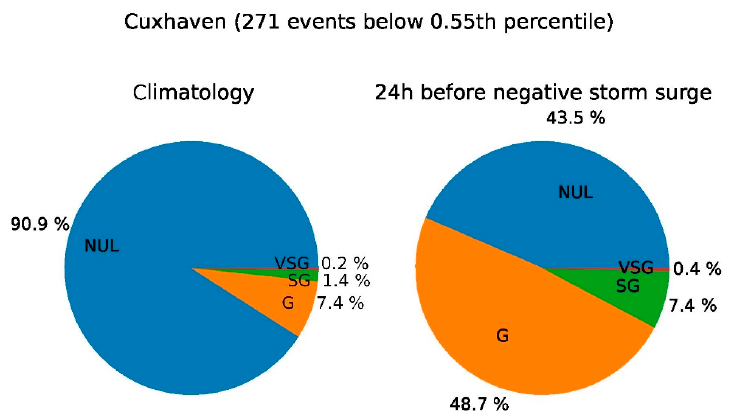
Figure 10. Left: Mean distribution of gale classes determined from daily means of ERA5 sea-level pressure for the entire period from 1950 to 2019. Right: Mean distribution of gale classes 24 h before ELW at Cuxhaven (LW below 0.55th percentile of all LW) between 1950 and 2019. While a storm (G, SG and VSG) occurs on average with a probability of about 9%, it occurs with a probability of about 56.5% during the 24 h before an ELW. This significant difference ( p < 0.001 tested via 10,000-fold bootstrapping) confirms the expectation that